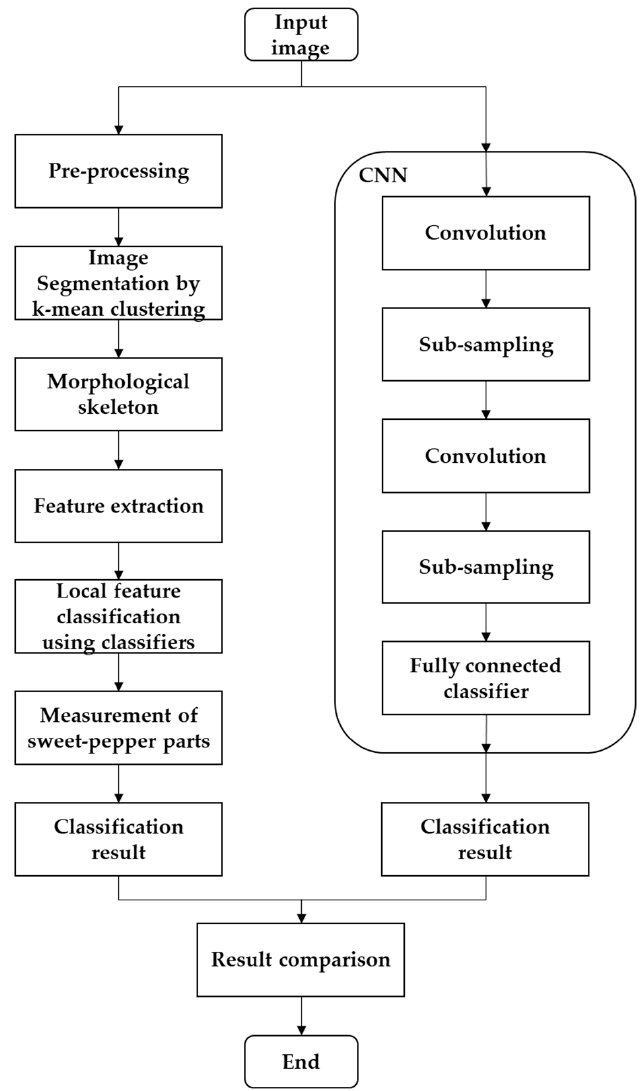
Figure 4. The classification process of sweet pepper plant parts.